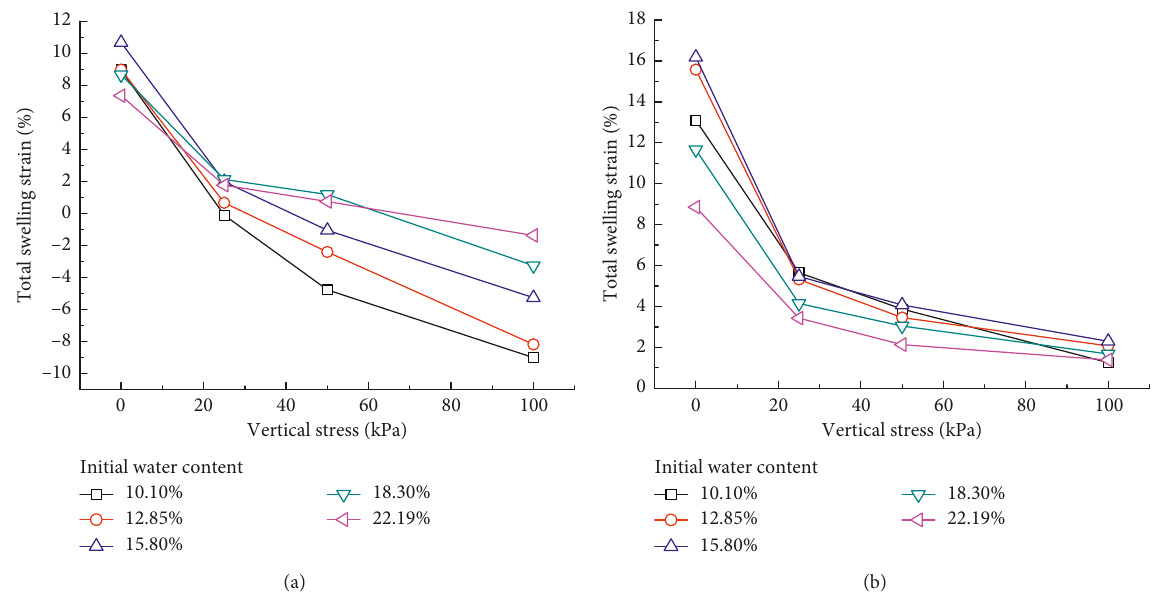
Figure 13: Relation of expansive deformation and axial stress for different dry densities. (a) Dry density of 0.14kN/m 3 . (b) Dry density of 0.16kN/m 3